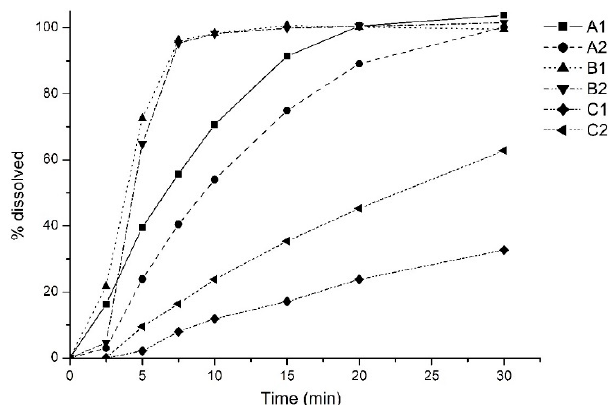
Figure 1. Dissolution profiles of products A1, A2, B1, B2, C1, and C2, obtained in USP Apparatus 1 (basket) with 900 mL of 0.1 M HCl at 37 ± 0.5 °C and 100 rpm for 30 min (adapted from [29], with permission from Brazilian Journal of Pharmaceutical Sciences , 2019).